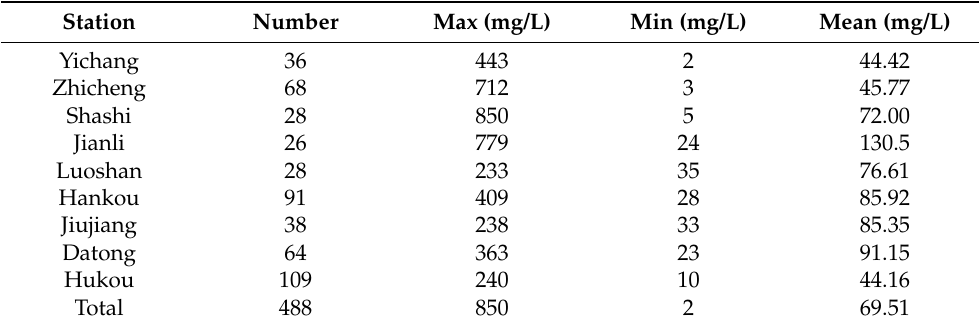
Table 1. SSC statistical summary of SSC at each gauging station collocated with the satellite observations.